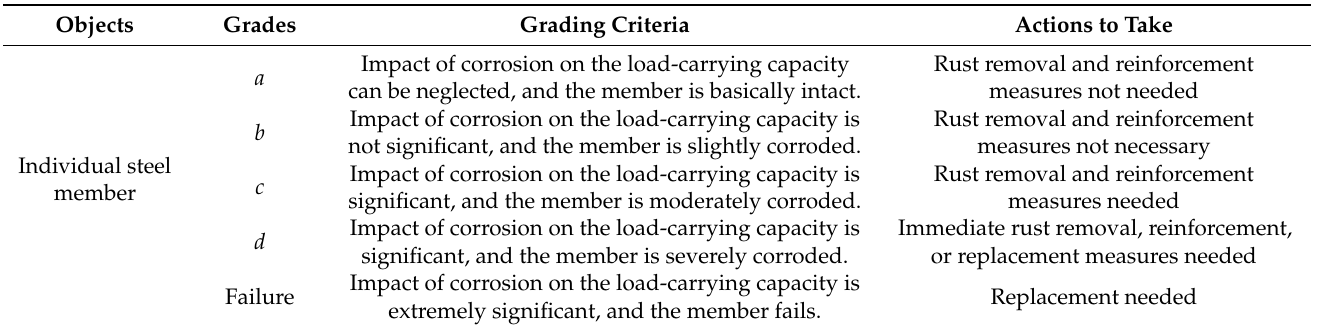
Table 10. Grading criteria for CCSTs under